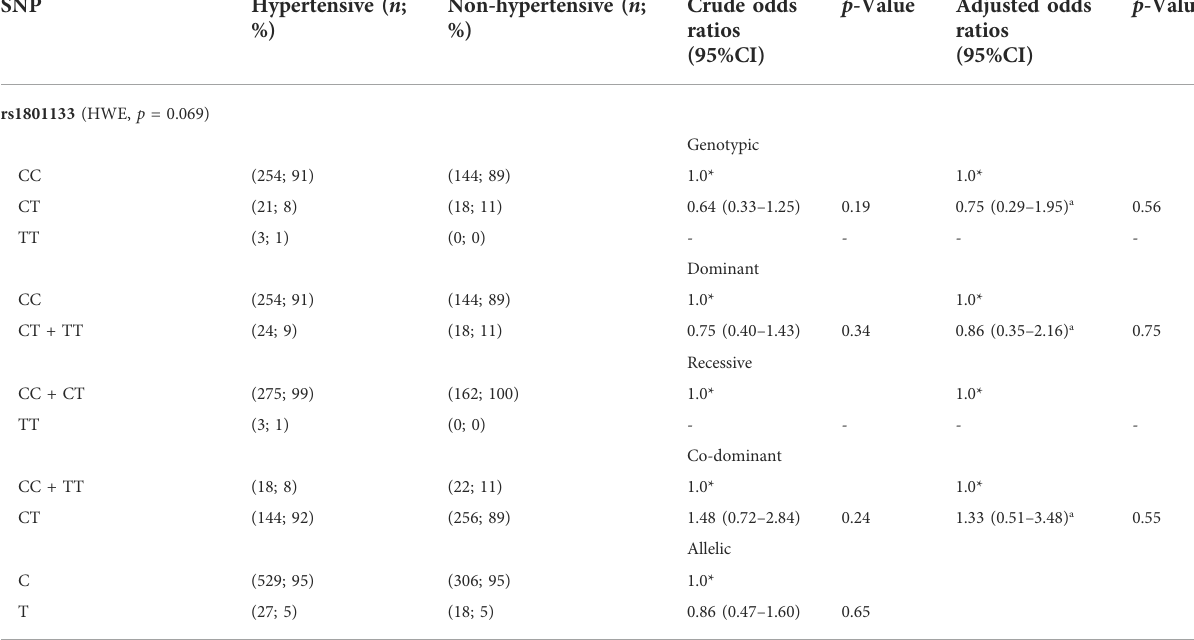
TABLE 3 Association of the MTHFR (rs1801133) polymorphism with risk of developing